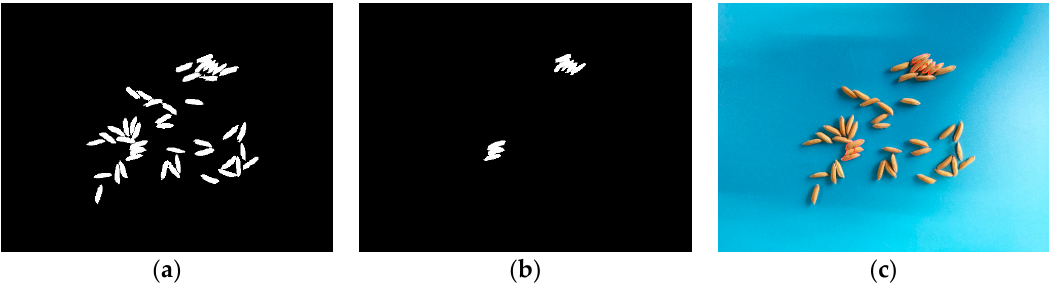
Figure 6. The result of the area threshold method; ( a ) Binary image of the Indica rice; ( b ) Indica rice grains that are not separated correctly; ( c ) The result image of algorithm (the touching area was outlined in red and the number of the kernels was displayed in the center of the touching area).